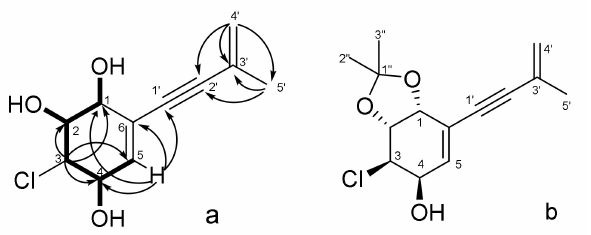
Figure 4. Key 1 H– 1 H COSY, 1 H– 13 C HMBC correlations of 4 ( a ) and chemical structure of acetonide derivatives 4a ( b